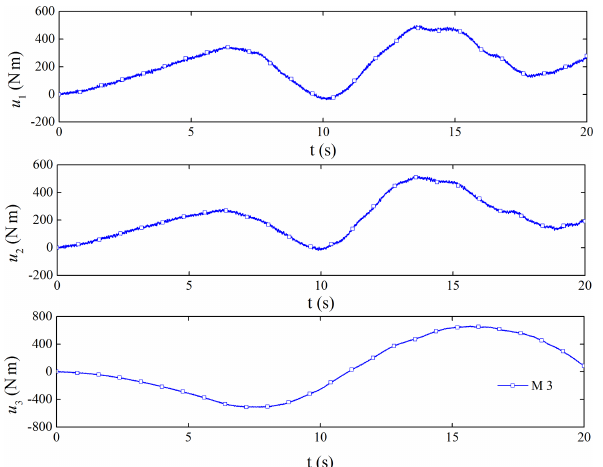
Figure 12. Control torque with a filter.